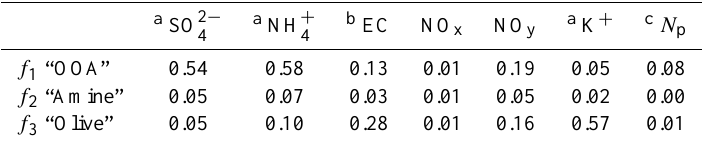
Fig. A2. Model residuals, E = X − GF , for the 2-factor (black lines) and the 3-factor (blue lines) PMF solutions as a function of time (summed over all m/z ’s) calculated in five different ways: (a) sum of residuals; (b) sum of the absolute value of residuals; (c) sum of residuals relative to total organics; (d) sum of absolute value of residuals relative to total organics, and (e) sum of squared, uncertainty-weighted (“scaled”) residuals, Q(t) = E(t)/S(t) , relative to expected values, Q exp (t) . Plots obtained with the PMF evaluation tool, PET, by Ulbrich et al. (2009). The structure in the residuals is decreased somewhat in the p = 3 solution compared to the p = 2 solution, primarily during the period of 19–21 March. Low OA concentrations result in high values for (c) and (d) during 4–9 March. Table A2. Correlations of PMF factors ( f i ) with ancillary data: 3-factor PMF